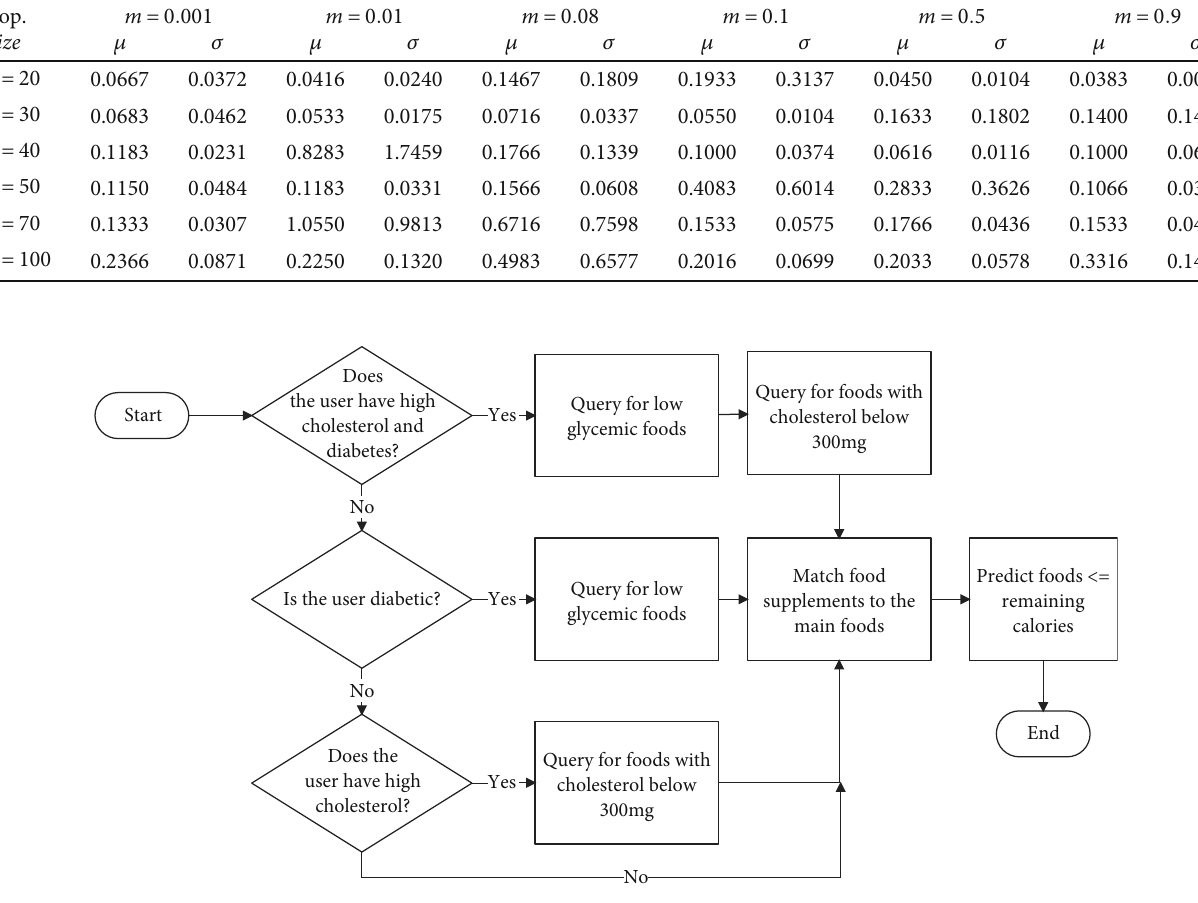
Figure 4: Operational logic diagram for the meal prediction